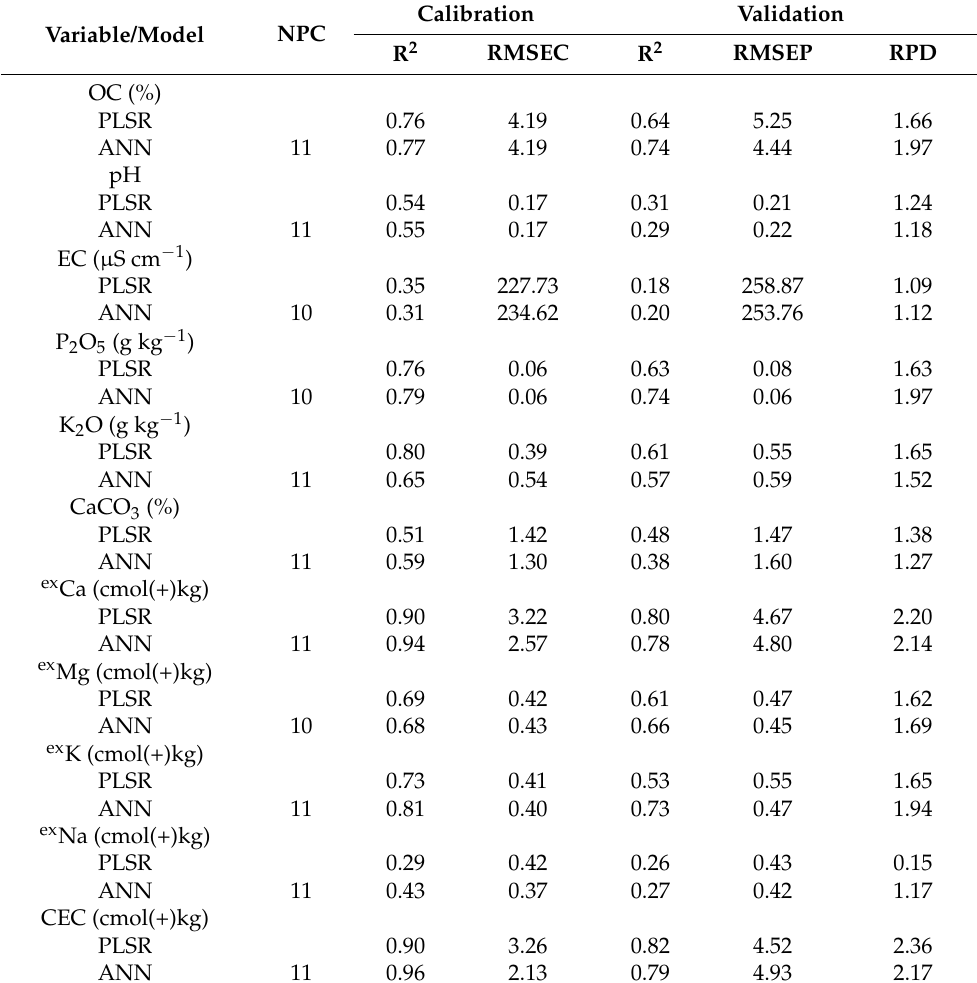
Table 7. Summary of calibration and validation results of PLSR and ANN models for soil chemical properties ( n =